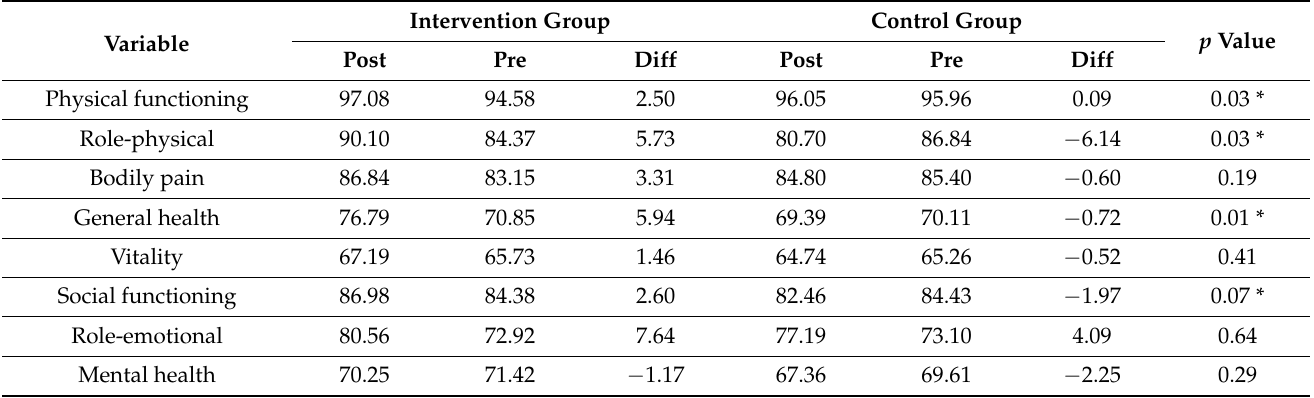
Table 1. Comparison of changes in quality-of-life scores between the two